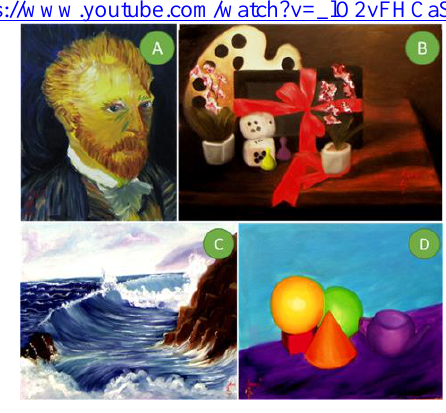
Figure 3. Paintings created within the art workshop: (a) a reproduction of a self-portrait by Vincent Van Gogh (section A), (b) a physical still life composition (section B), (c) a geometric seascape composition (section C) and (d) a composition exercise using 3D models (section D).